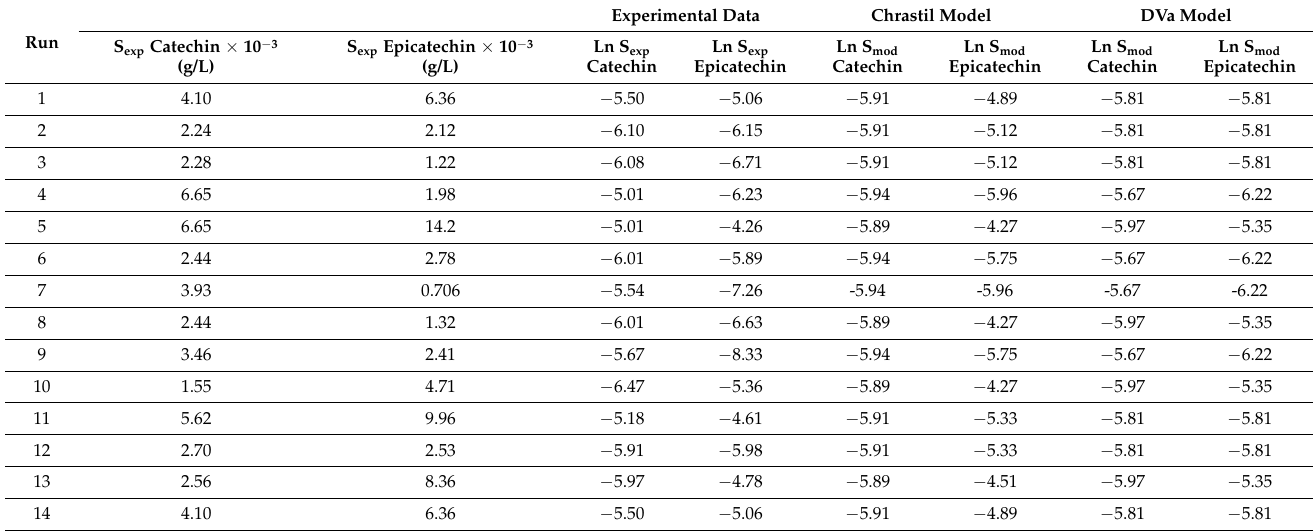
Table 5. Experimental and calculated solubility of catechin and epicatechin in subcritical methanol. Experimental Data